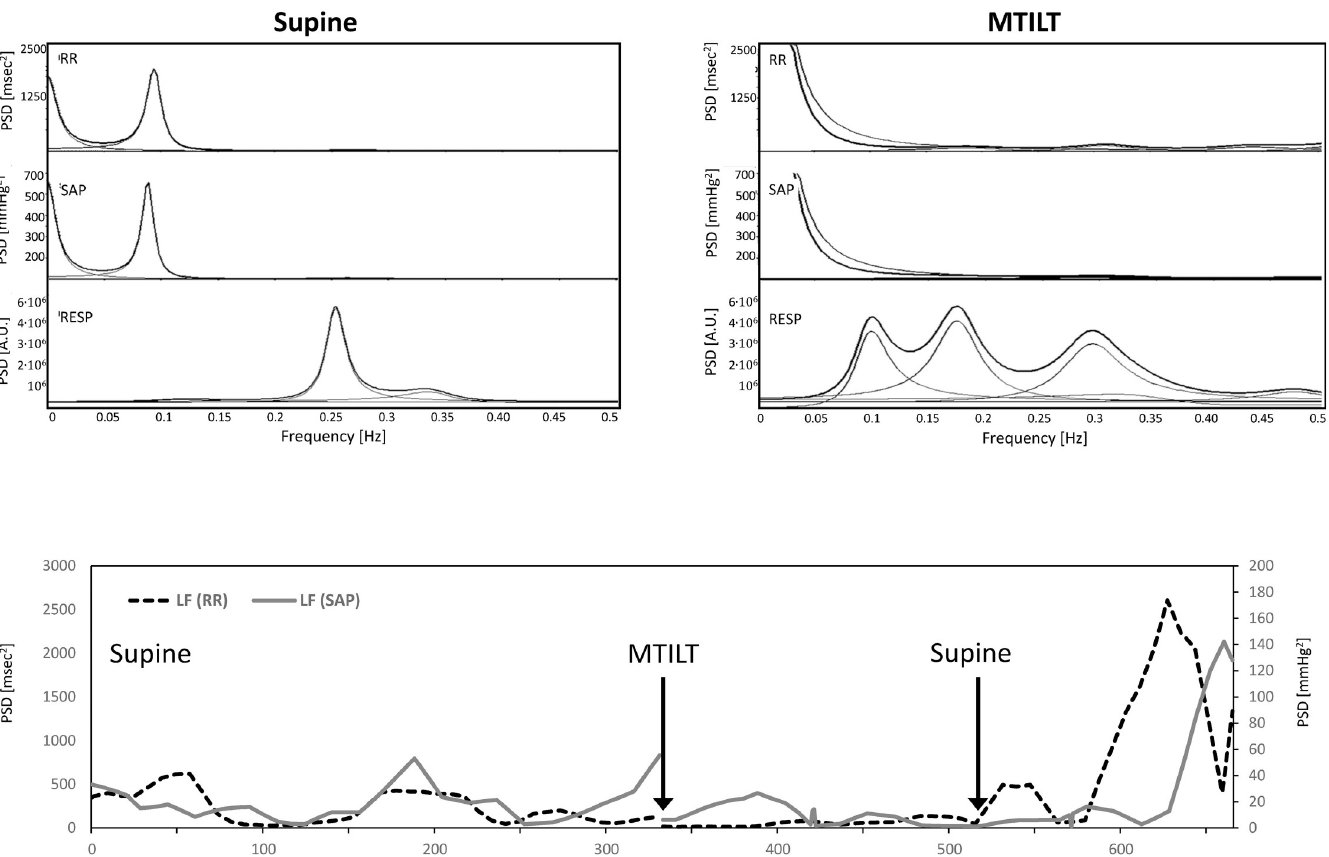
Fig 3. Graphical representation of heart period and systolic pressure variability of a patient admitted to ICU during the prodromal phase and passive modified tilt (MTILT). At the top, the power spectra derived from 300 beats at baseline and during MTILT are shown. MTILT induced a marked reduction of LF spectral densities of heart period and SAP. At the bottom, the pattern of LF spectral densities of heart period and SAP changes assessed by wavelets analysis is shown. Both LF densities reappeared after the MTILT interruption. PSD , power spectral